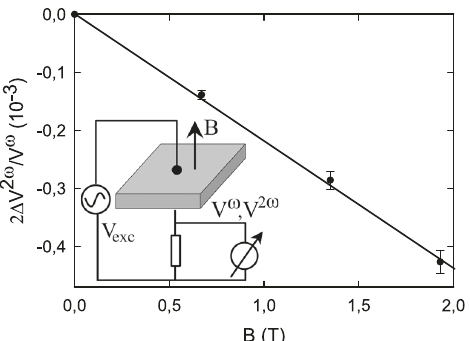
Fig. 1 Field dependence. Magnetic fi eld dependence of the MChA of a + poled TGS sample at 321 K and at 50 kHz and 10 V/mm. Solid line is a linear fi t, error bars represent standard deviation on repeated measurement. Inset shows the schematic setup.